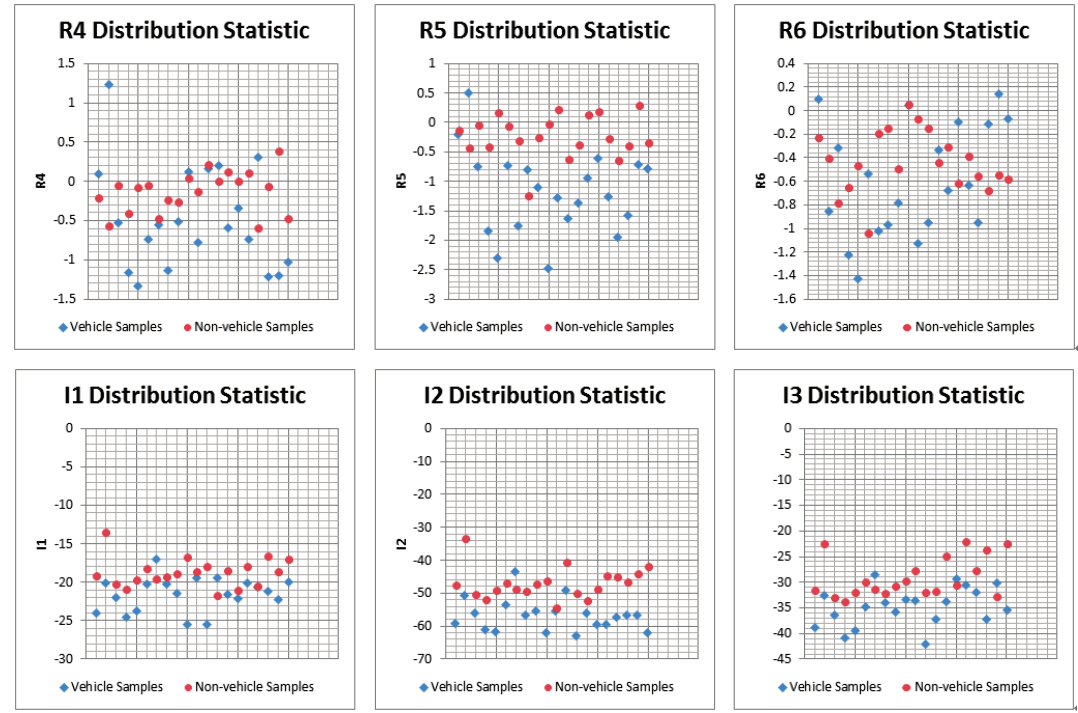
Figure 9. Statistics of the moment with different samples.